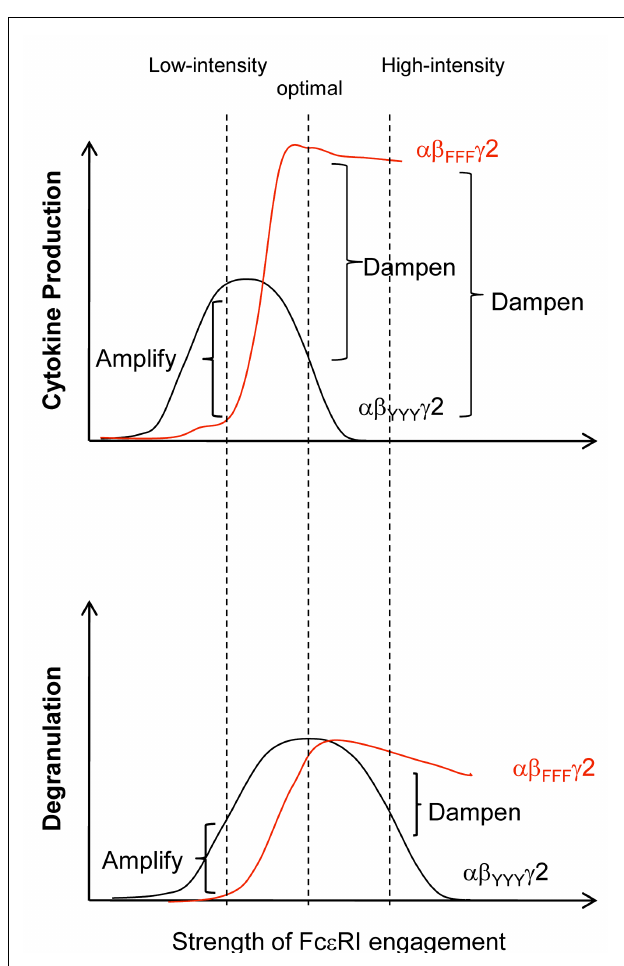
FIGURE 5 | Positive and negative regulation of Fc ε RI-dependent mast cell activation by the Fc ε RI β ITAM. Y → F β ( αβ FFF γ 2) mast cells exhibit reduced degranulation and cytokine production following exposure to a “low-intensity” stimulus (left dashed line), whereas the cells exhibit increased degranulation and cytokine production following exposure to a “high-intensity” stimulus (right dashed line).The Fc ε RI stimulation that induces the optimal degranulation response of wild-type ( αβ YYY γ 2) mast cells (middle dashed line) triggered a normal degranulation response but increased cytokine production in αβ FFF γ 2 mast